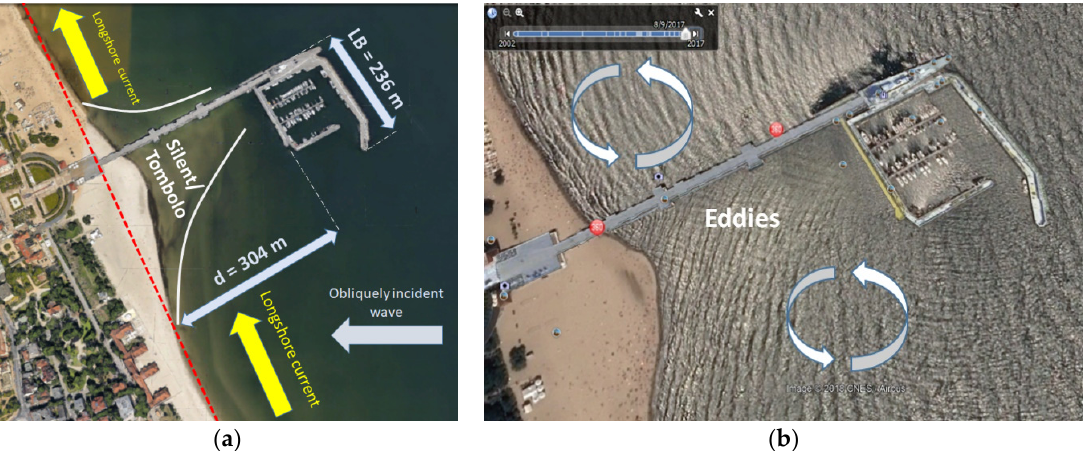
Figure 1. The nature of the phenomenon that causes the formation of the tombolo effect ( a ), and the wavy surface of the sea in varying directions resulting from the diffraction of waves around the wavy surface of the sea in varying directions resulting from the di ff raction of waves around the marina marina breakwater in Sopot ( b ). breakwater in Sopot ( b